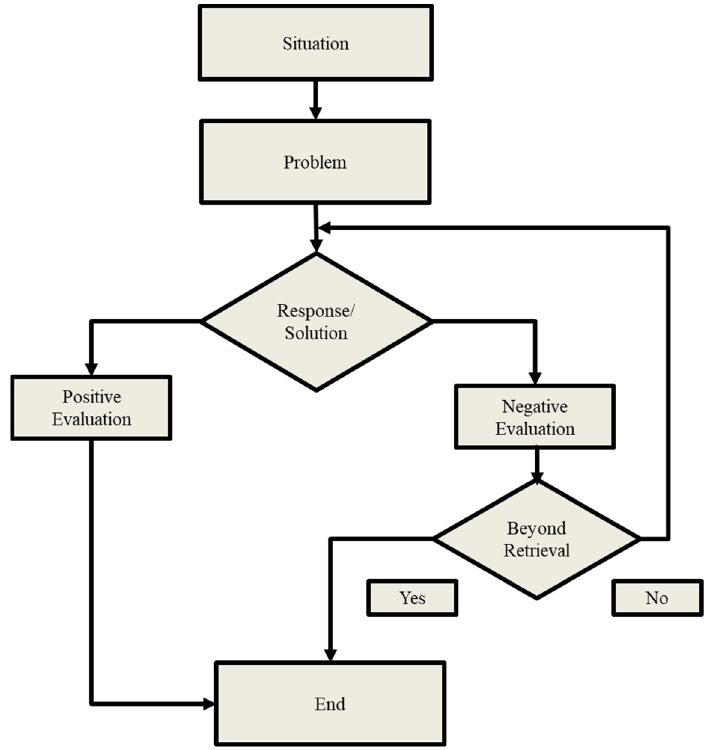
Figure 2. SPRE Model given by Hoey.